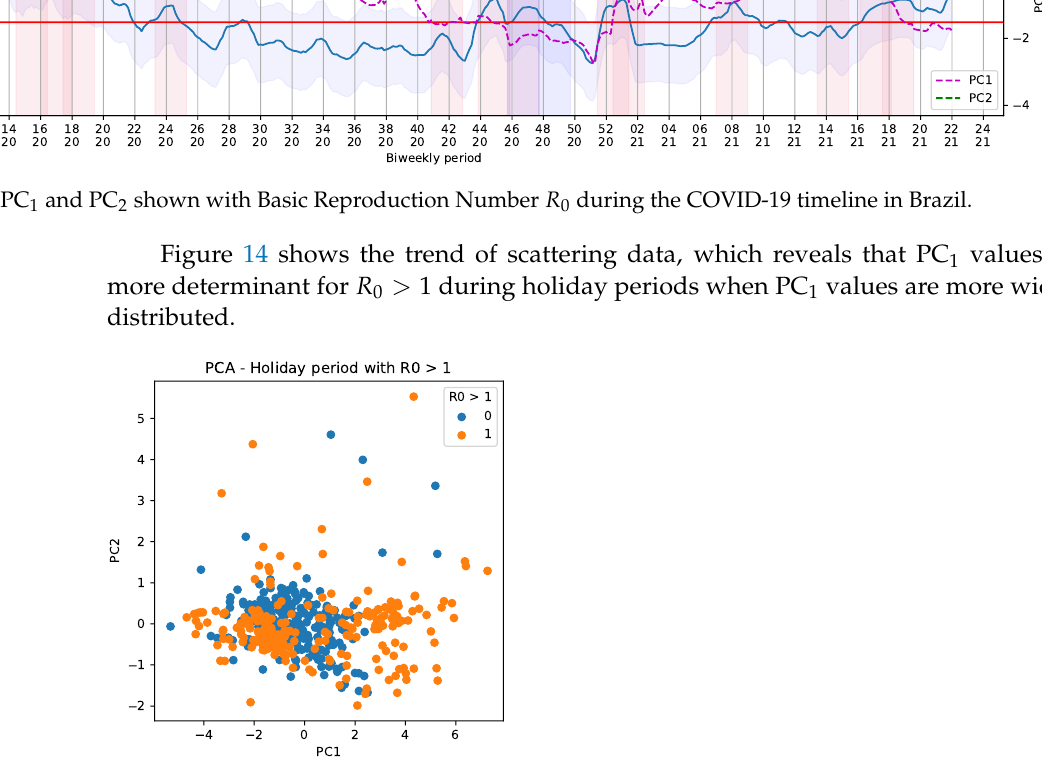
Figure 14. PC scattering based on mobility reports considering R 0 > 1 and the holiday period. A point with a value of 0 indicates that it is not a holiday, whereas a value of 1 indicates that it is a holiday